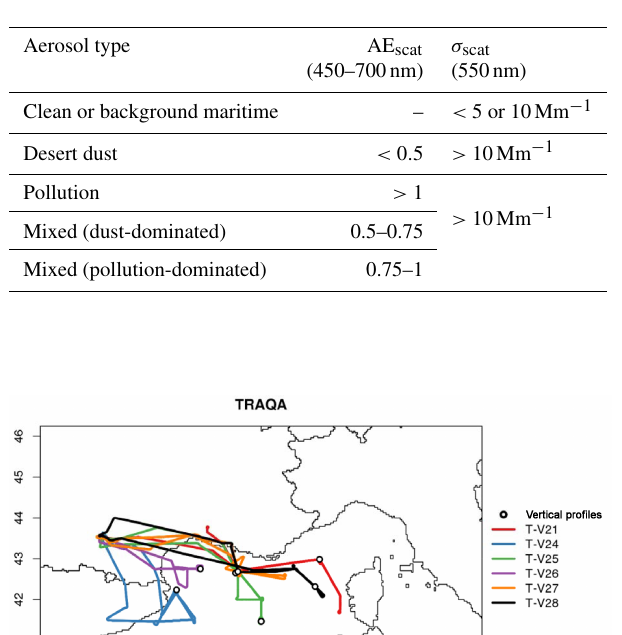
Table 3. Criteria for classification of aerosol layers encountered on the vertical profiles of TRAQA and ADRIMED, based on nephelometer measurements of the scattering coefficient ( σ scat ) at 550nm and on its spectral dependence (AE scat ) between 450 and 700nm.